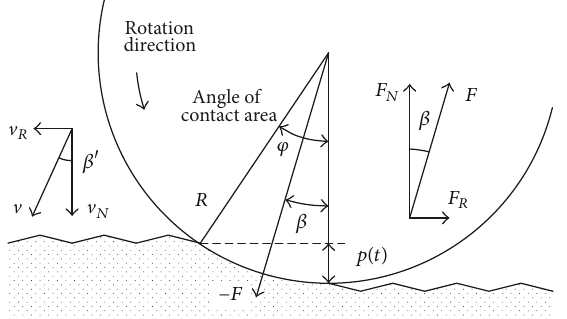
Figure 3: Generalized illustration of cutter-rock